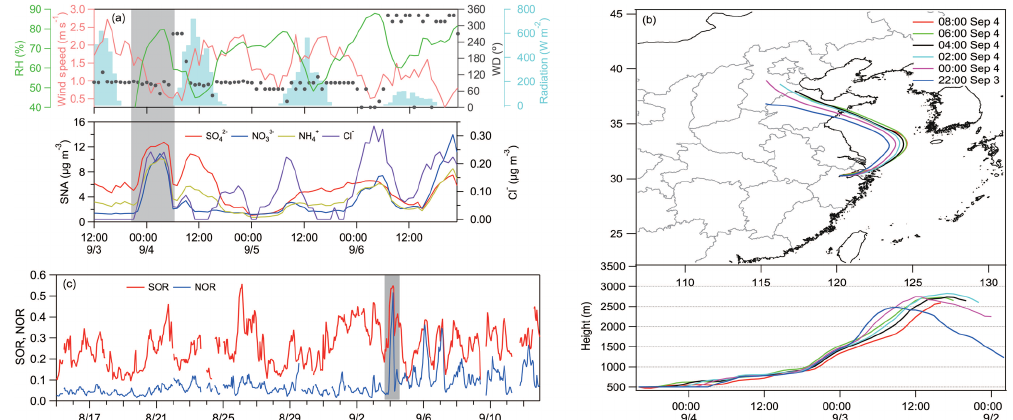
Figure 7. (a) Time series of hourly concentrations of SNA, Cl − , and meteorological parameters (WS, WD, RH, and radiation) during S4. (b) 48h air mass backward trajectories for the short pollution episode on the morning of 4 September 2016. (c) Hourly variations in the sulfur oxidation ratio (SOR) and the nitrogen oxidation ratio (NOR) during the entire study period. The highlighted period in panels (a) and (c) represents the short pollution episode on the morning of 4 September